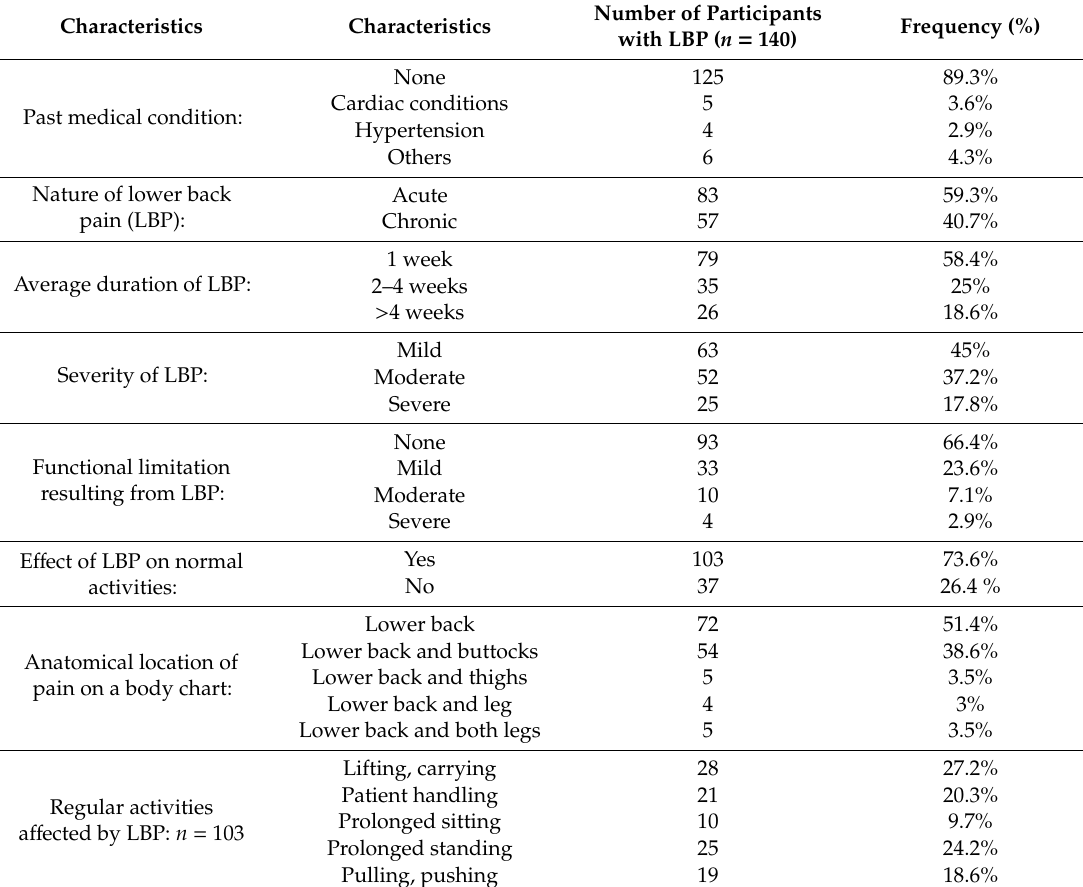
Table 3. Characteristics of low back pain among the included